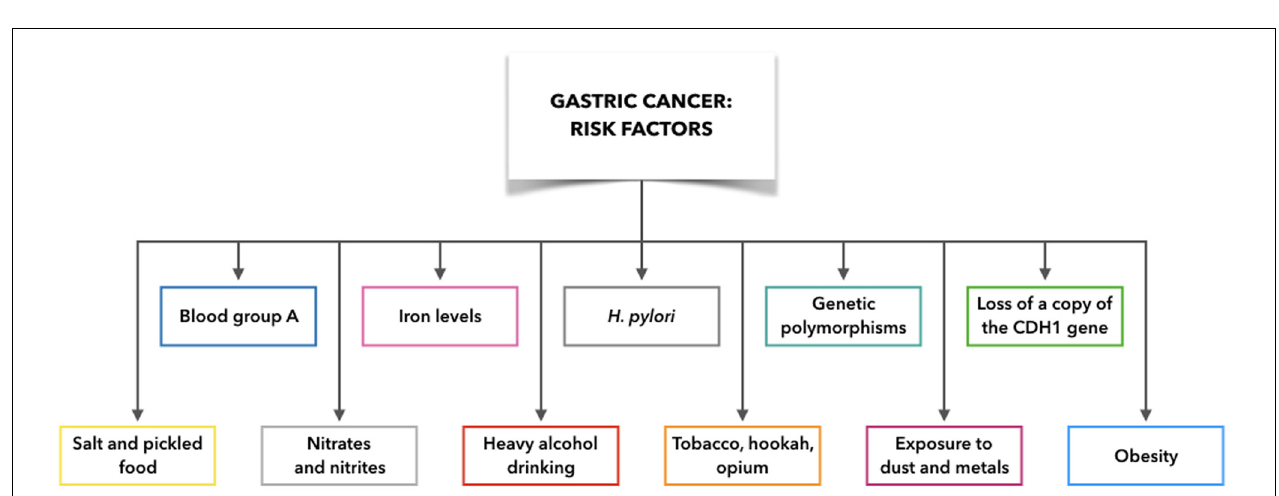
FIGURE 2 | Gastric cancer risk factors: what make people more likely to get gastric cancer. CDH1: cadherin 1.